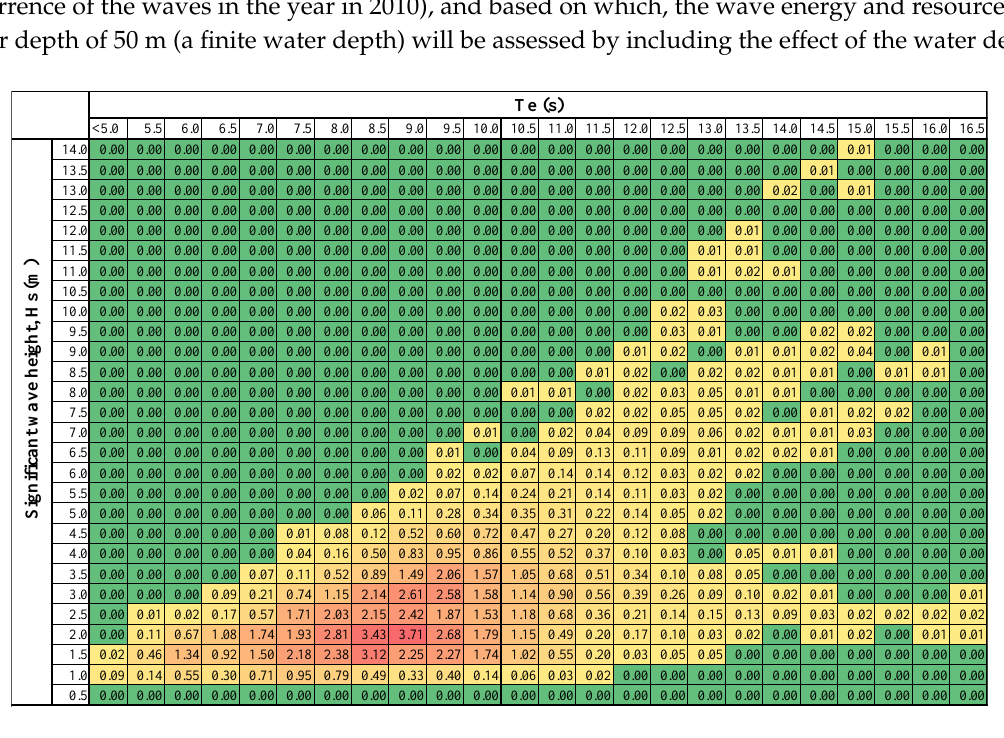
Figure 20. Scatter diagram of the waves in AMETS in 2010 (available data points 13,189 for two wave buoys with 75% availability, detailed description can be found in [7]).